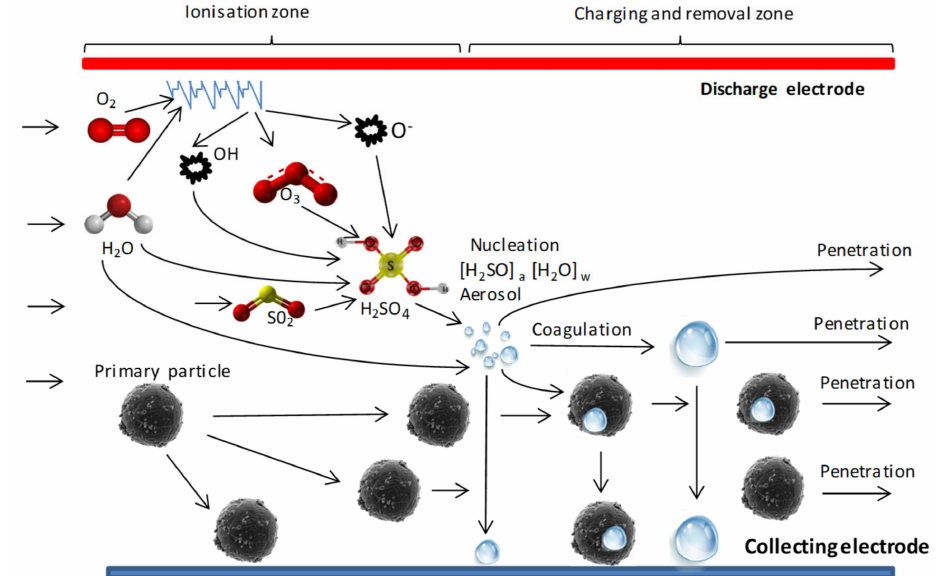
Figure 7. Schematic model of particle formation and precipitation in the